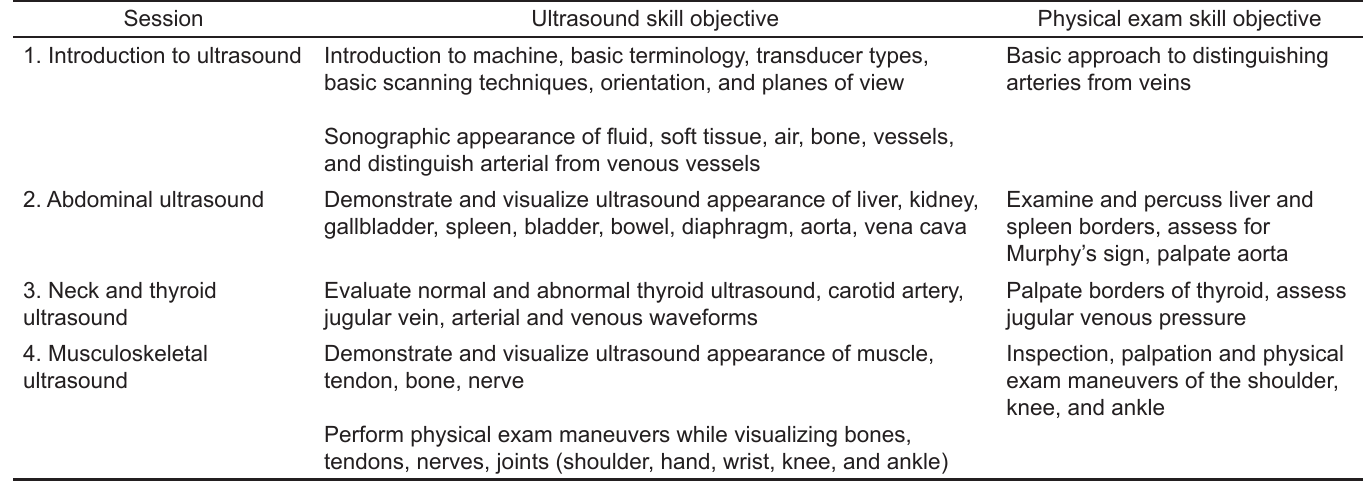
Table 2. Ultrasound curriculum for PGY (postgraduate year)-2 physical exam